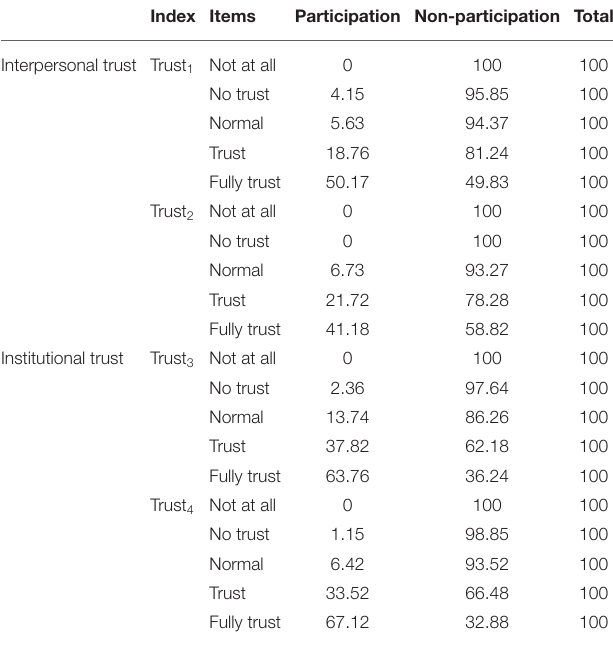
TABLE 2 | Influence of trust on the participation behavior of farmers. Index